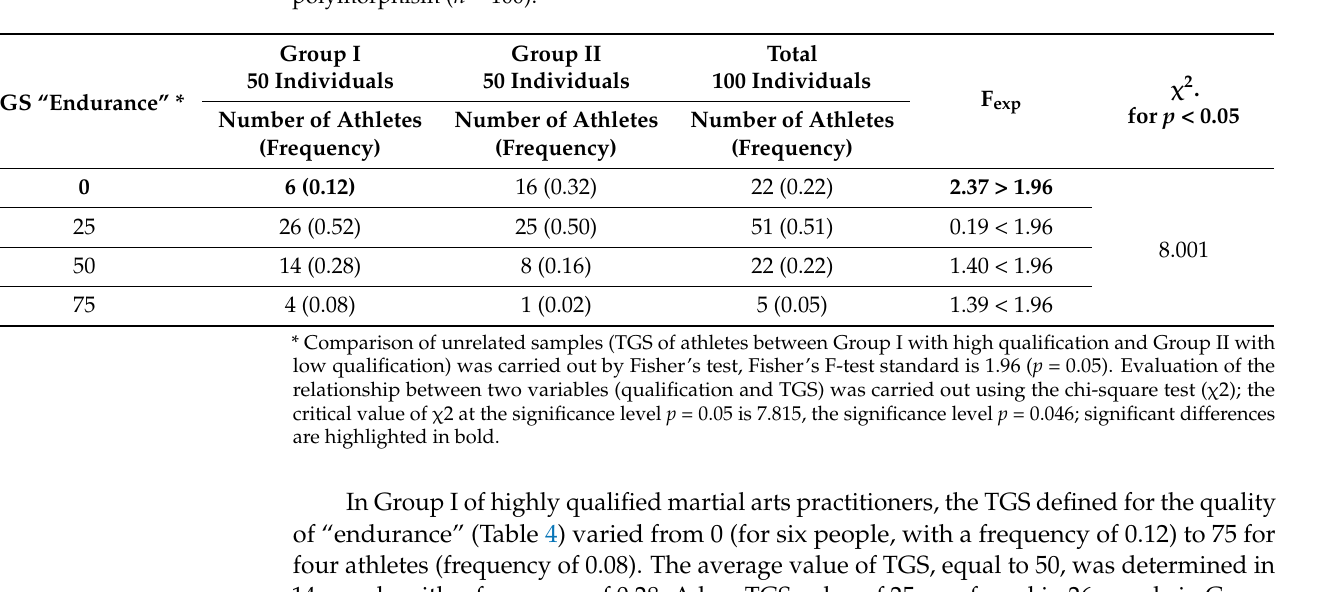
Table 4. The total genetic score of martial arts practitioners is based on ACE and BDKRB2 genes polymorphism ( n = 100).